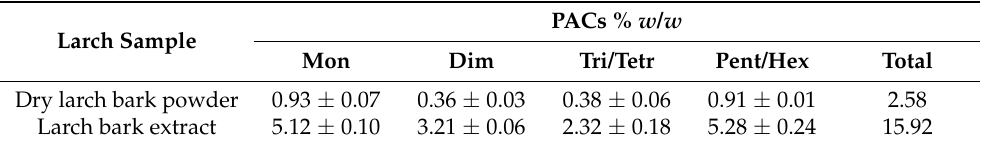
Table 1. Amounts of different PACs polymeric classes in larch bark dry powder and larch bark extract. Data were obtained by HPLC-FLD analysis and are expressed as % w / w ± SD. Larch